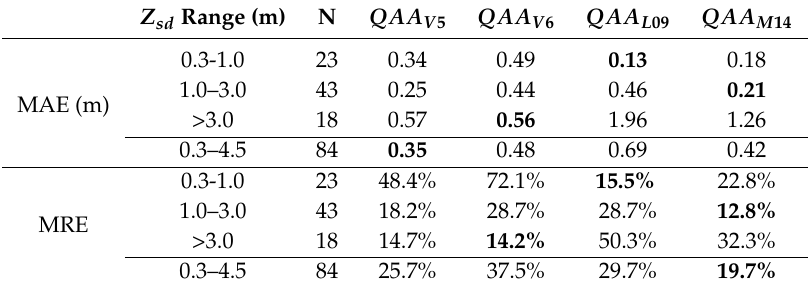
Table 3. The MAEs and MREs of the estimated Z sd from the AHSI in situ R rs based on the semi-analytical methods using various QAA algorithms. Optimal results listed in